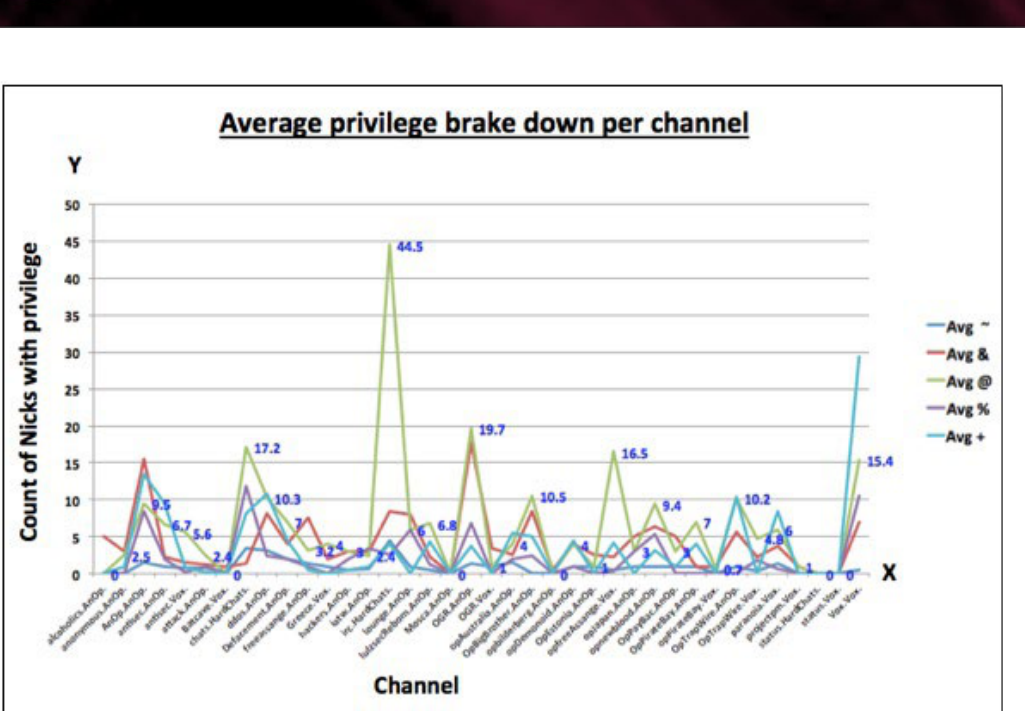
Figure 6: nick to channel count, broken down by assigned privilege The chart shown above gives a number of insights into the relationship between privileges within Anonymous